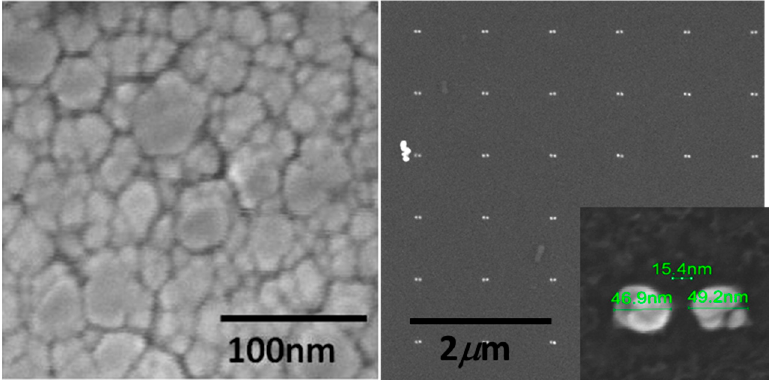
Figure 4. Left: SEM picture of the gold sputtered SERS surface; Right: SEM image of an array of dimers, and magnified picture of the nanodimer.